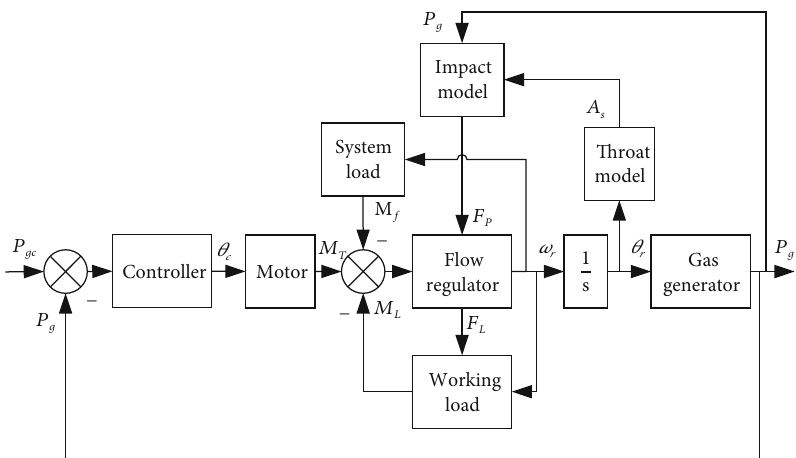
Figure 5: System block diagram of the fl ow regulator including the load model.